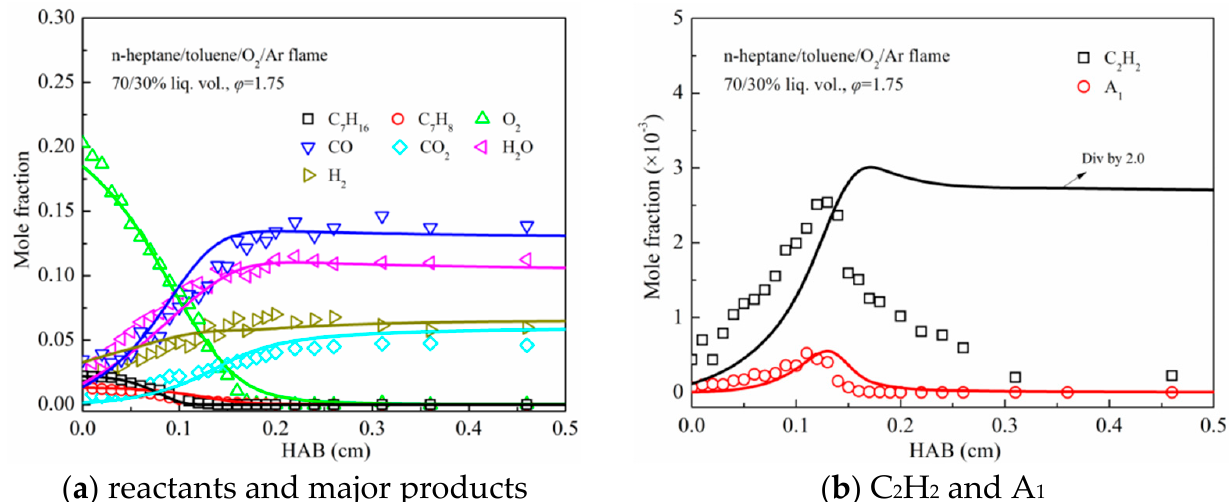
Figure 7. Measured [45] (symbols) and predicted (lines) species profiles in premixed toluene flame. Knyazkov et al. [46] investigated the speciation data for a premixed fuel-rich ( ϕ = 1.75) atmospheric pressure n-heptane/toluene mixture (70%:30% by liquid volume) flame by employing molecular beam mass spectrometry. As shown in Figure 8, the proposed mecha- nism’s simulated species concentrations of n-heptane/toluene flame are compared with that of experimental data of reactants, major combustion products and two intermediate species. It is evident from Figure 8a that the proposed mechanism can well reproduce the experimental data of n-heptane, toluene, O 2 and major products (CO, CO 2 , H 2 and H 2 O). In addition, the present mechanism satisfactorily predicts the A 1 molecule mole fraction (see Figure 8b), but the experimental data of the C 2 H 2 mole fraction are not reasonably predicted by the present mechanism. The peak value of the C 2 H 2 mole concentrations is obviously overpredicted. Meanwhile, the present mechanism significantly overpredicts the C 2 H 2 mole concentration in the post-flame zone compared to the experimental data; similar results were also obtained by Knyazkov et al. [46]. This discrepancy may be due to the lack of some important combustion chemistry of C 2 H 2 species in the present mechanism.